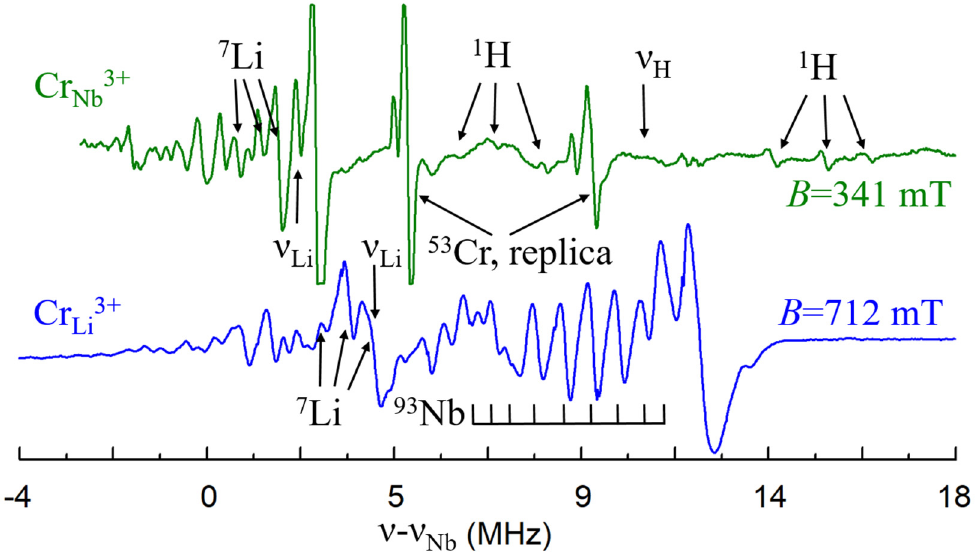
Figure 14. The ENDOR spectra of Cr 3+ Li (high-field EPR transition) and Cr 3+ Nb (central EPR transition) at B || x , T = 5 K. To facilitate a comparison of the spectra, they were shifted to the 93 Nb Larmor